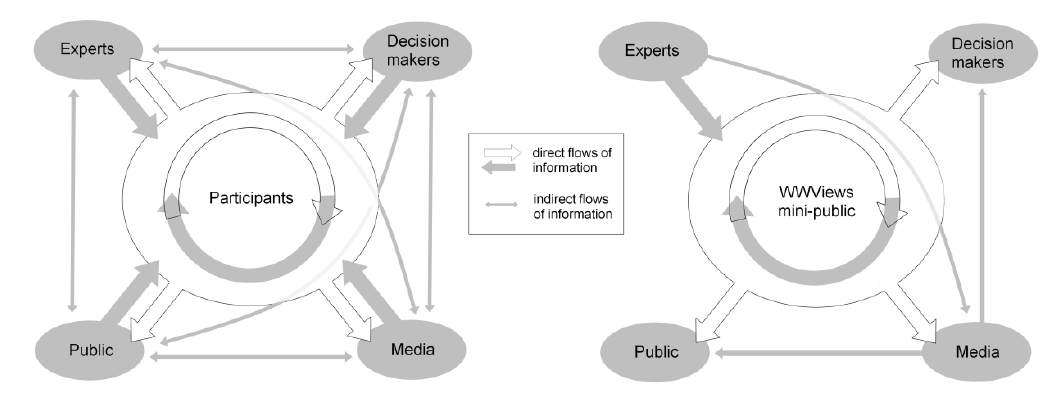
Fig. 5: The left-hand side of the figure represents possible flows